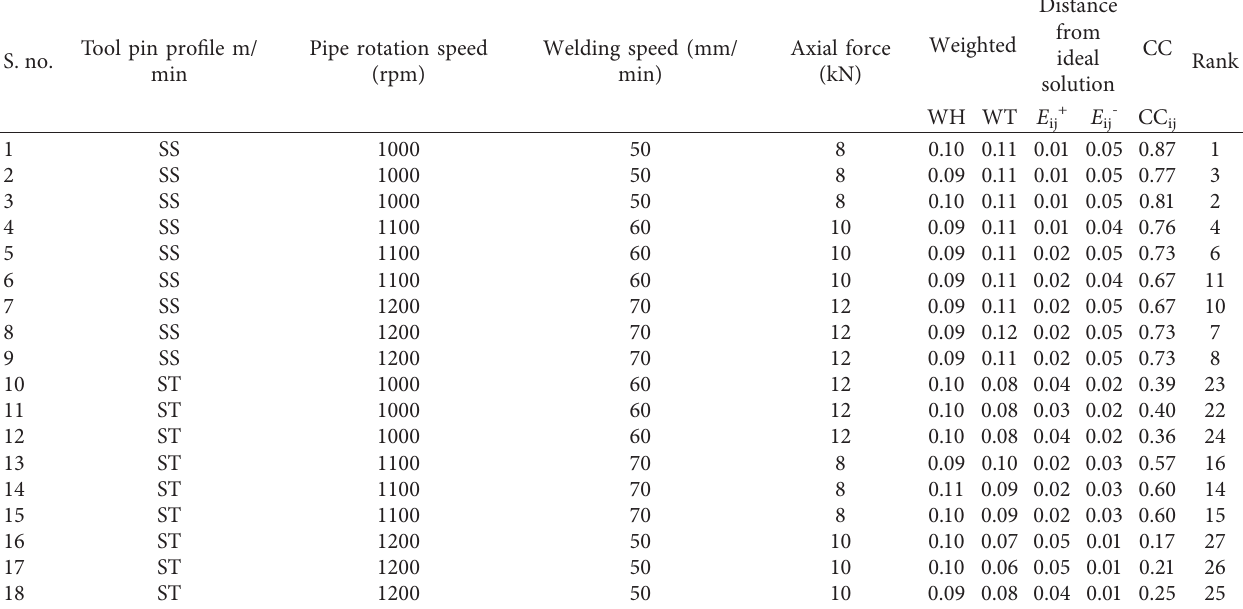
Table 8: TOPSIS evaluation for cryogenic friction stir welding of AISI 4340